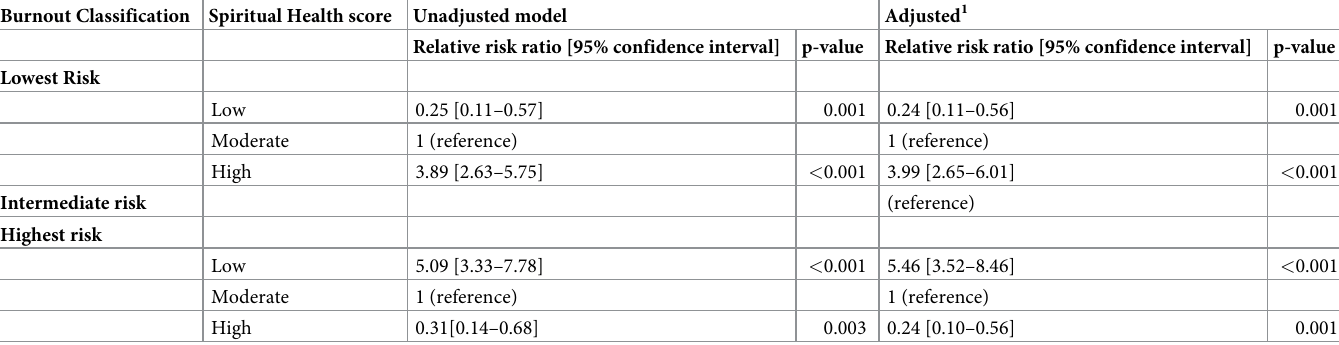
Table 4. Association between spiritual health score and risk of burnout: Multinomial logistic regression analysis. Burnout Classification Spiritual Health score Unadjusted